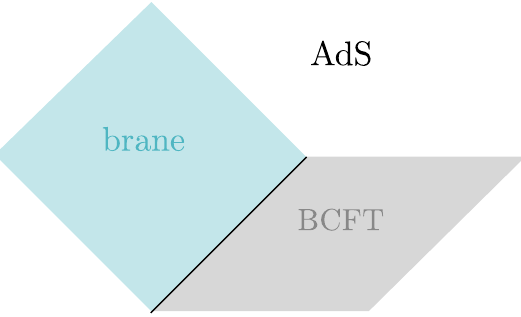
Figure 4. Our simple model in which the bulk is locally AdS d +1 , but is terminated by an ETW brane. We depict here the AdS